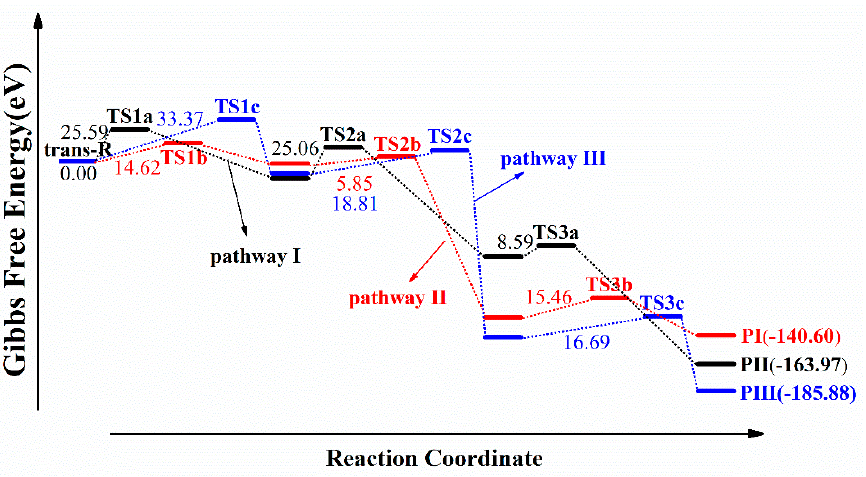
Figure 10. Profile of the potential energies of the intermediate products. Figure 10. Pro fi le of the potential energies of the intermediate products. Ames mutagenicity and developmental toxicity of PYR and its intermediates were evaluated using the toxicity evaluation software tool (T.E.S.T.), as shown in Figure 11. Most intermediates exhibit low mutagenicity (Figure 11a). Some of the degradation intermediates showed relatively low developmental toxicity (Figure 11b), suggesting that the degradation process of PYR is accompanied by detoxification. Notably, the developmental toxicity of intermediates P4, P5, P8, and P2 was higher than that of PYR. However, their content is small and rapidly further mineralized into Cl − , NO 3 − , CO 2 , and H 2 O. The results show that the gas–liquid discharge plasma degradation process can effectively degrade PYR and reduce its ecotoxicity. Gas–liquid discharge plasma wastewater treatment can be considered a green technology with great practical potential in eliminating PYR in water